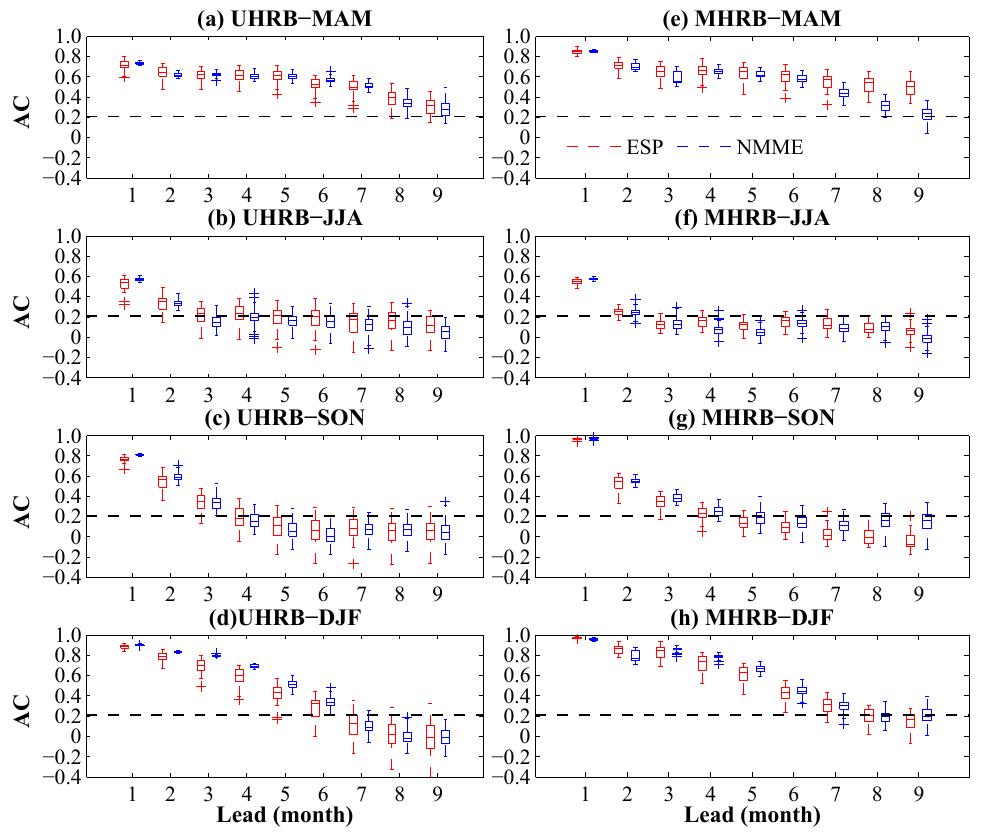
Figure 9. Anomaly correlation (AC) of the forecast of seasonal SSI1. The red box plots show the spread of AC of each member from NMME, and the blue box plots show that from ESP. The blue (red) crosses show the outliers for NMME (ESP) forecast skill. The dashed black line indicates the threshold (AC = 0.21) of 95% confidence intervals calculated from the t test. The predictions and simulations are carried out with the human activities module switched